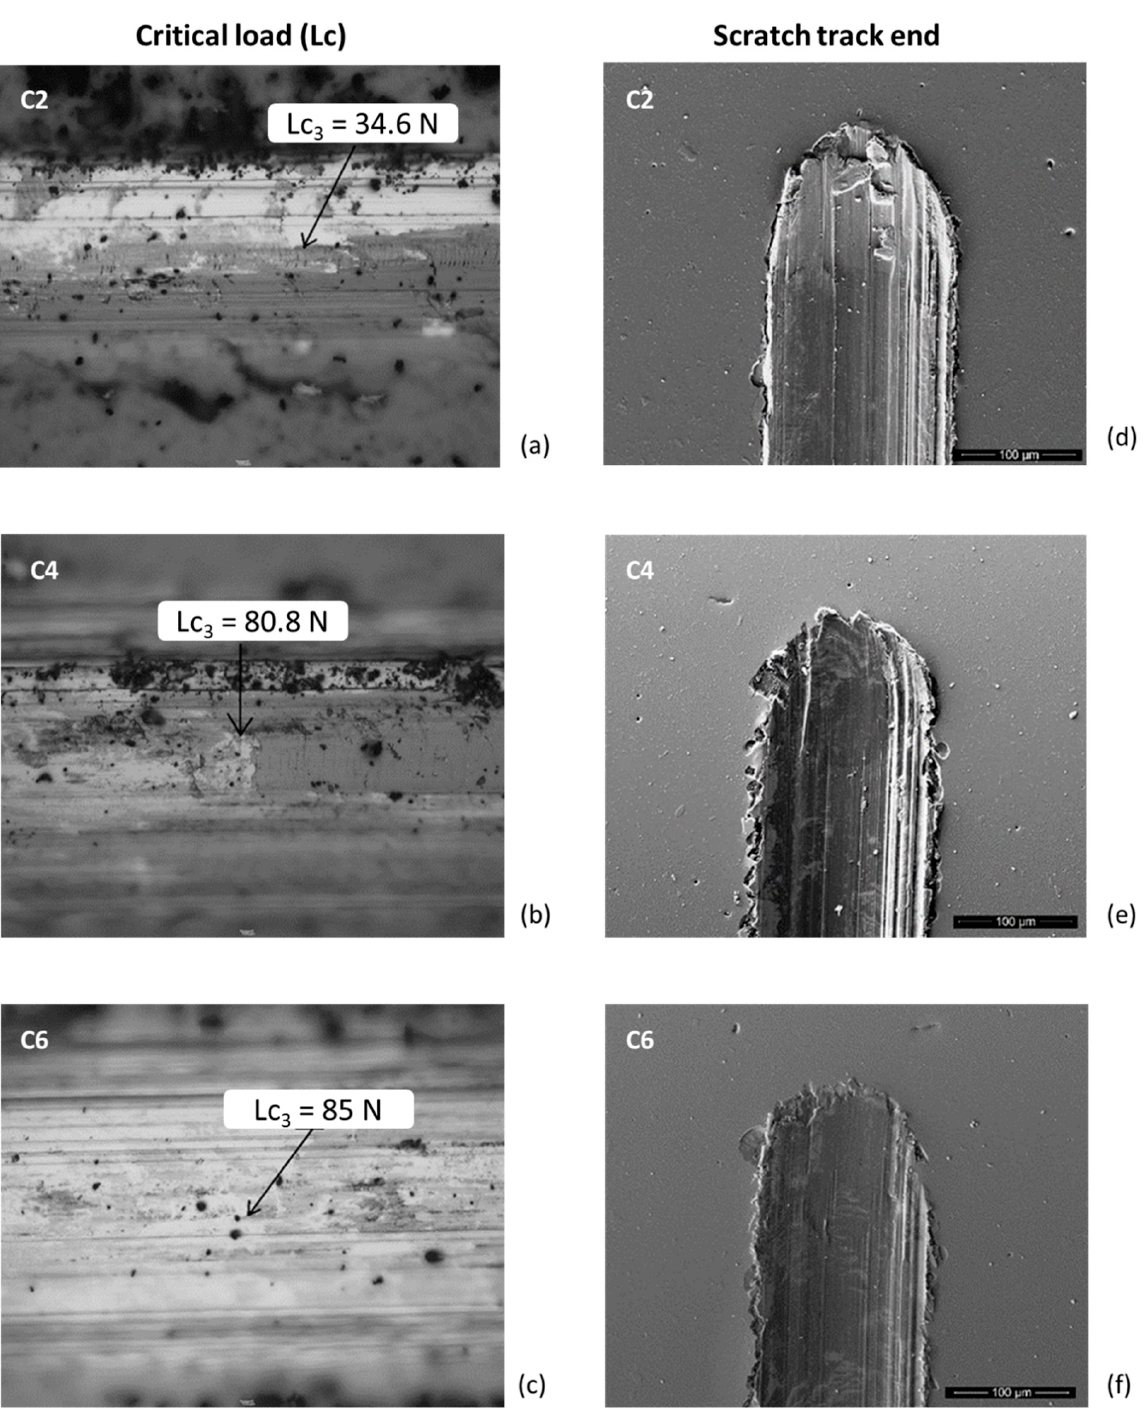
Figure 4. Adhesion strength of C2, C4 and C6 demonstrating ( a – c ) individual critical load (Lc 3 ) and ( d – f ) SEM images of the respective scratch track ends for 100 N applied load .